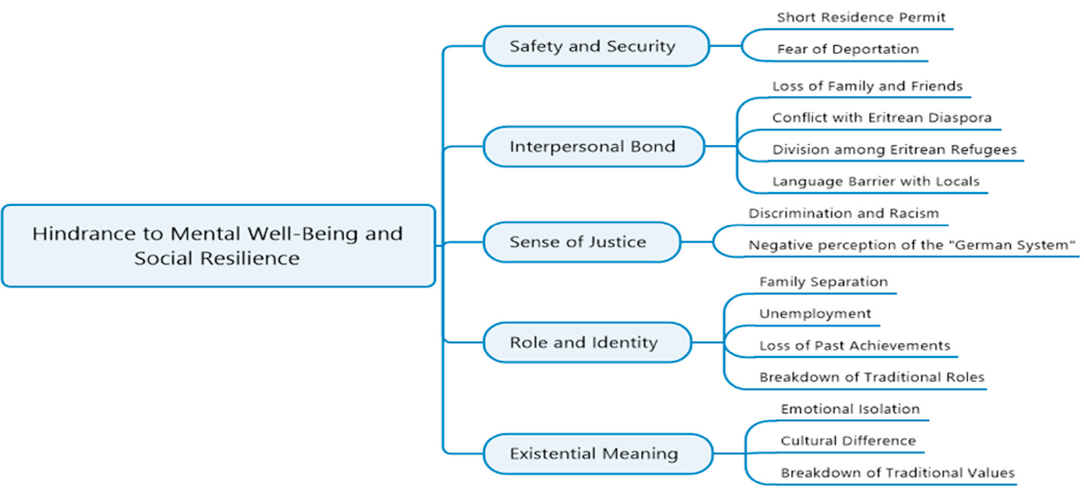
Figure 1. Hindrance factors to mental wellbeing and social resilience (based on the ADAPT model [26]).